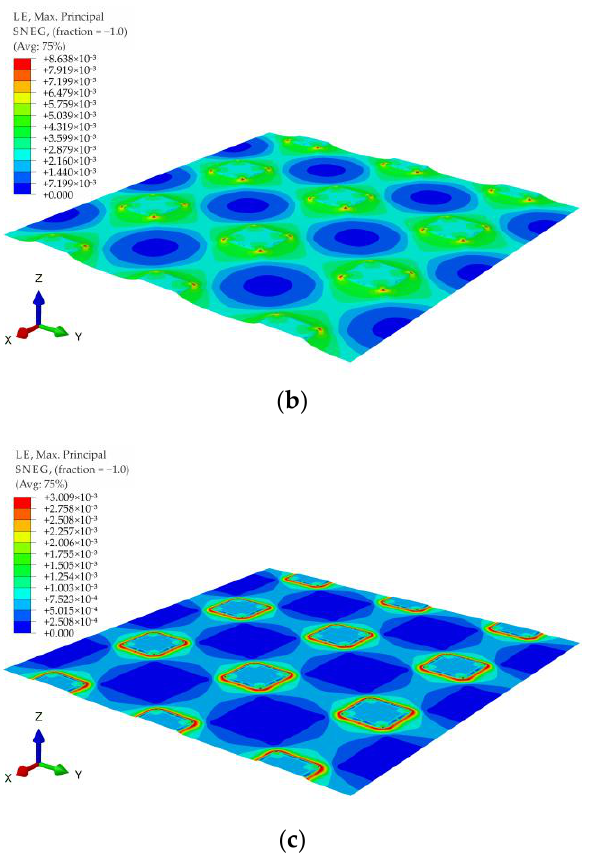
Figure 21. Deformation and maximum principal strain in reinforcement, variant A2: ( a ) k = 10 kN/m 3 , ( b ) k = 150 kN/m 3 , ( c ) k = 500 kN/m 3 .